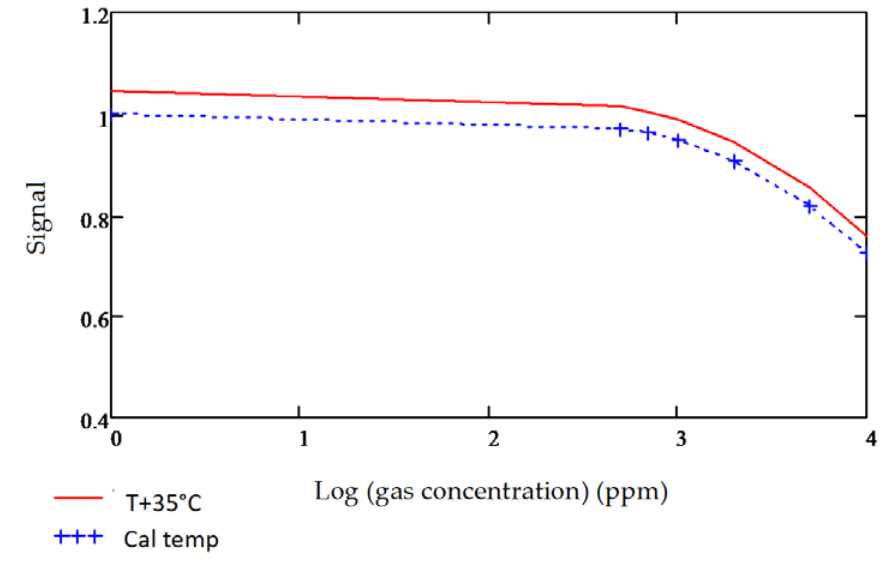
Figure 12. Source–Detector–Filter product for methane gas